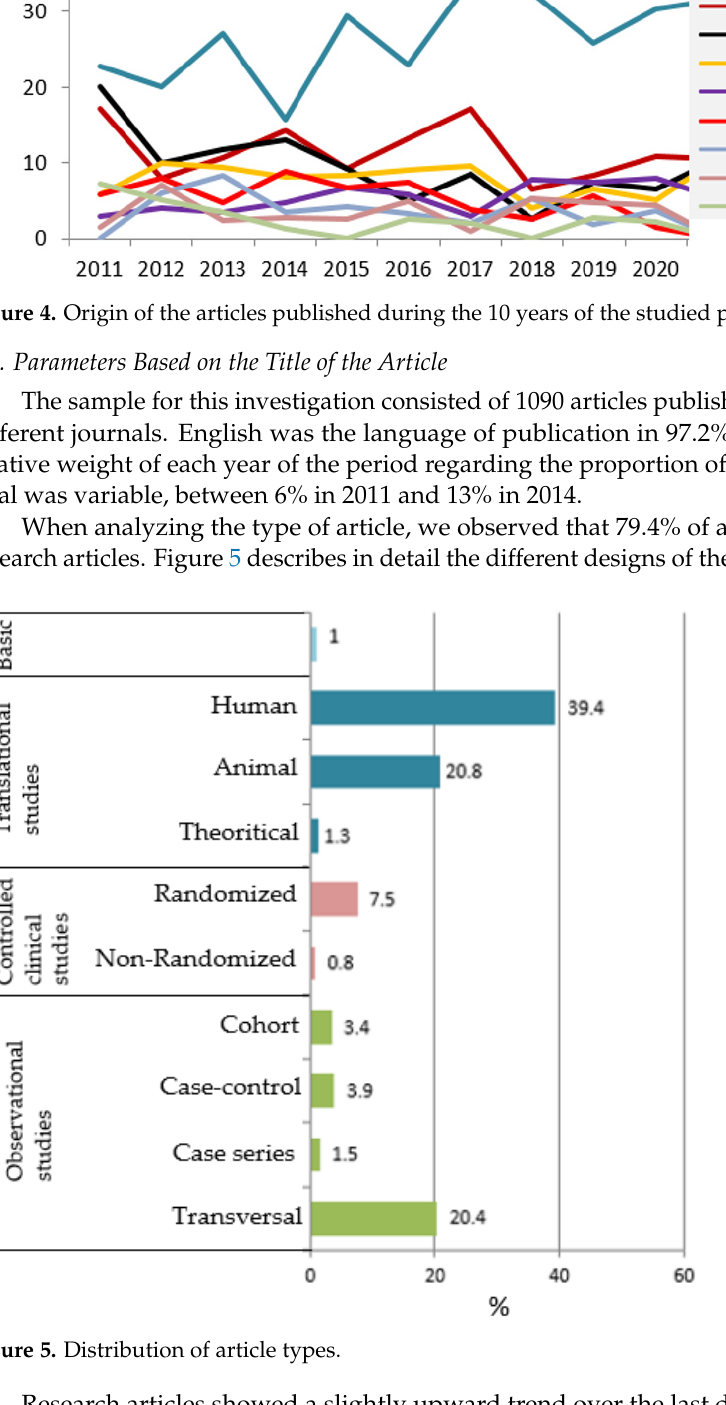
Figure 3. Origin of affiliation of the published articles